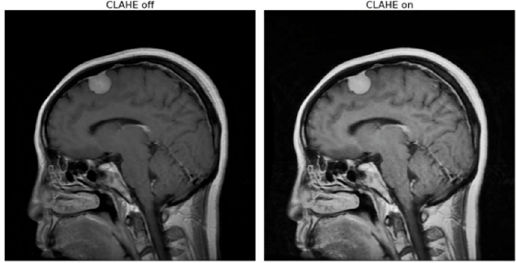
Figure 2. An example of CLAHE process.